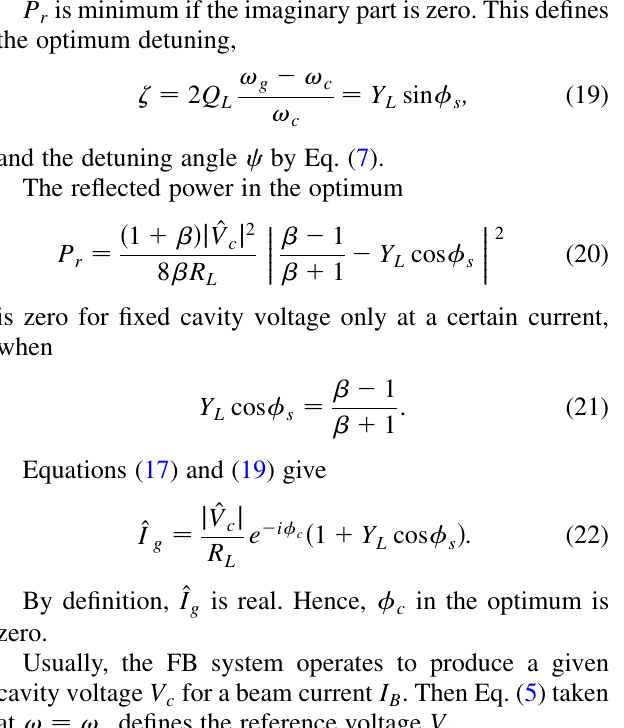
FIG. 3. (Color) Real part of the impedance for several values of the FB gain H . The impedance starts to grow at large H and can cause instability at the rf sidebands for detuned cavities. PEP-II LER parameters, see